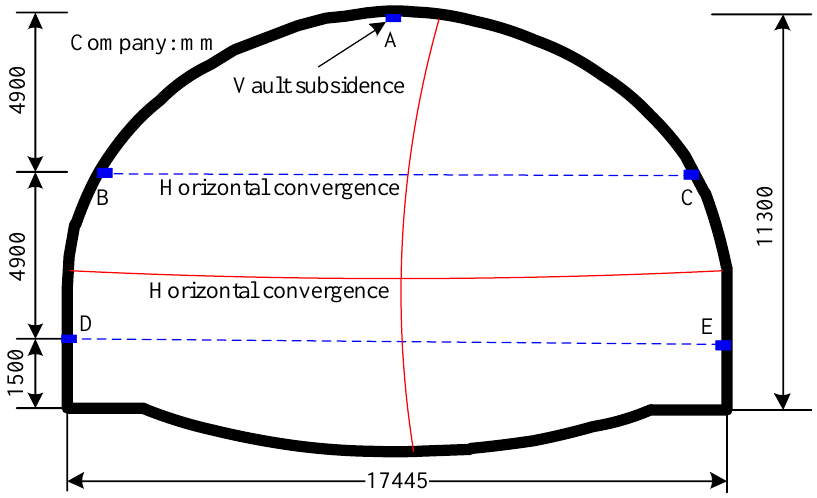
Figure 2. Layout of measuring points for the tunnel. A is the vault subsidence monitoring point. B and C are the horizontal convergence monitoring points of the upper step of the tunnel. D and E are the horizontal convergence monitoring points of the lower step of the tunnel.